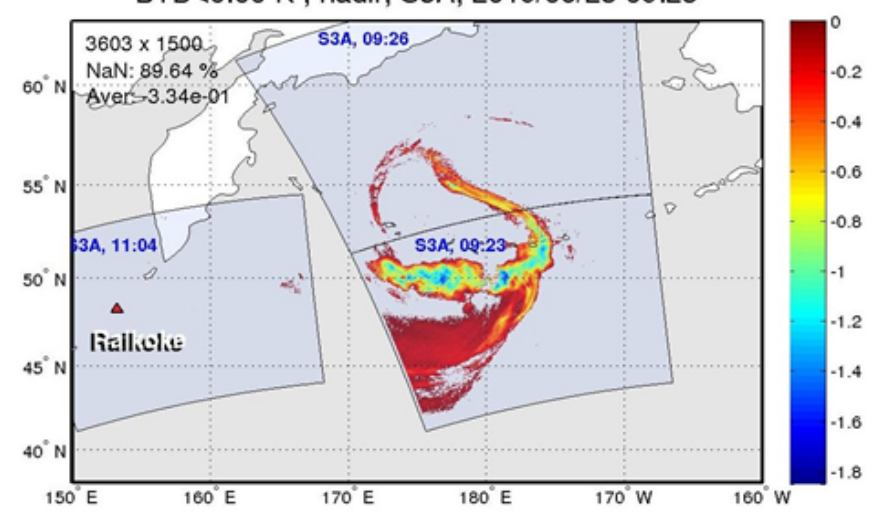
Figure 4. Ash index (brightness temperature difference, in K) from the SLSTR sensor on board Sentinel-3A on 23 June 2019. Please note that the date format in this figure is yyyy/mm/dd.